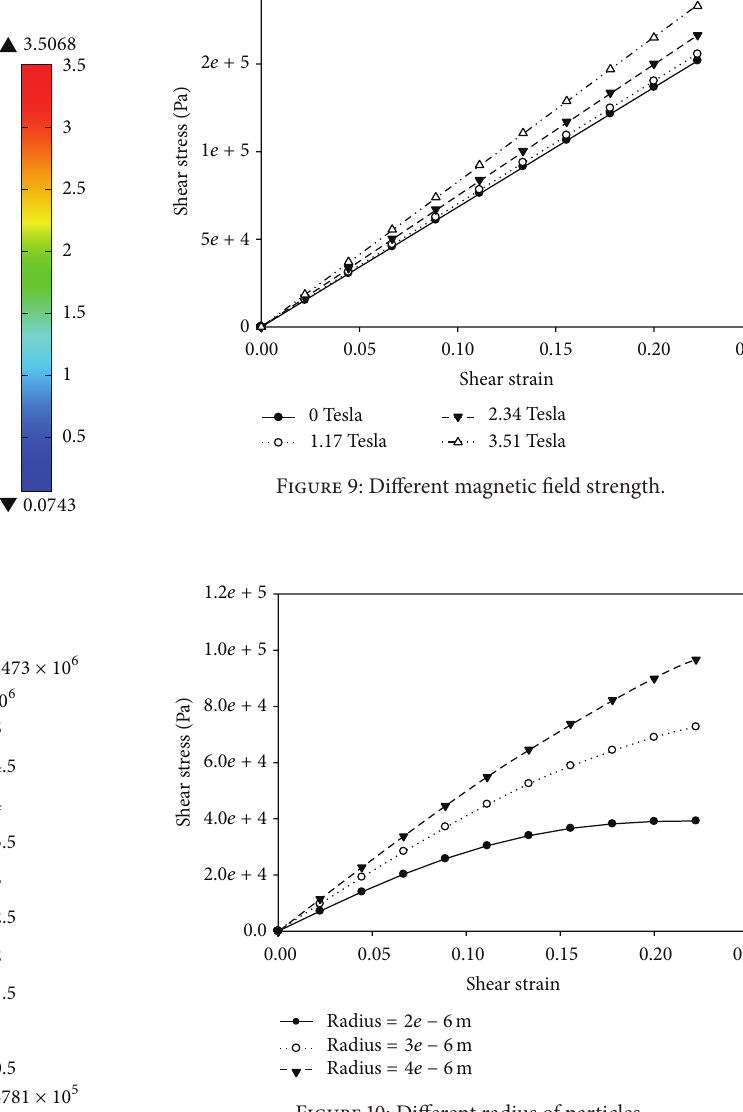
Figure 10: Different radius of